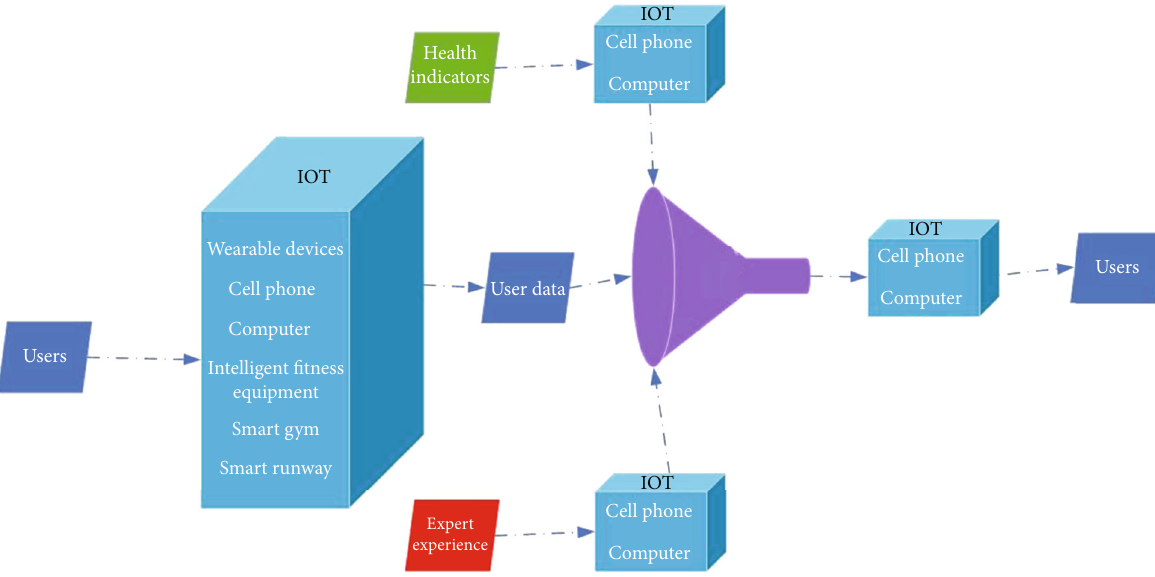
Figure 1: Structure diagram of smart sports health system. Table 2: Dataset parameters.